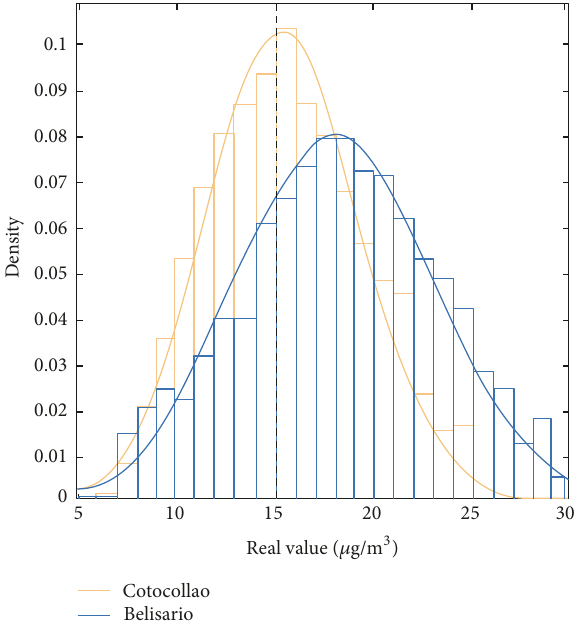
Cotocollao Figure 4: Distribution of PM 2.5 concentrations (June 2007 to July 2013) for Cotocollao and Belisario. Dashed black line represents the national standards and the class seperation boundary (15 𝜇 g/m 3